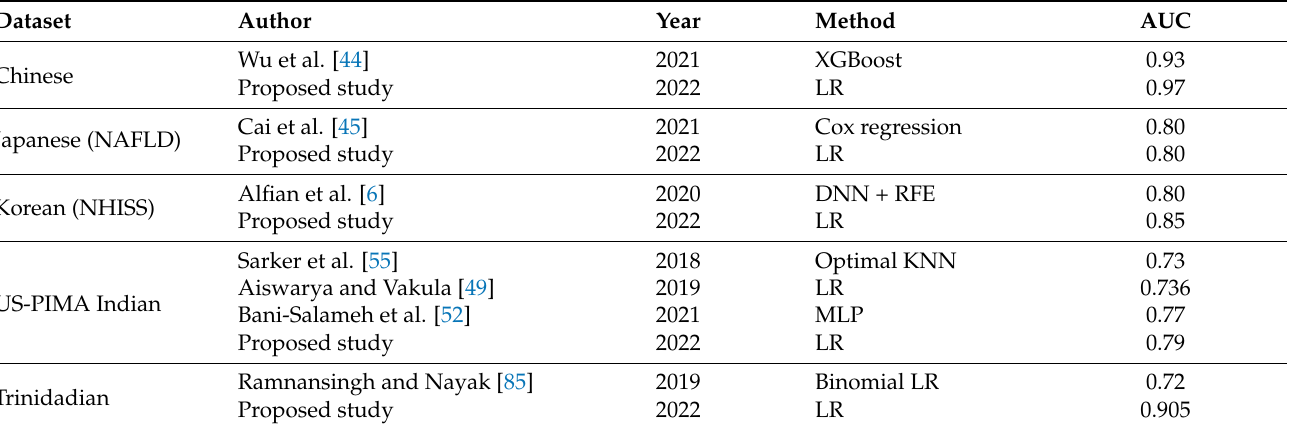
Table 9. Performance of proposed study as compared to earlier works for diabetes prediction in Chinese, Japanese, Korean, US-PIMA Indian, and Trinidadian